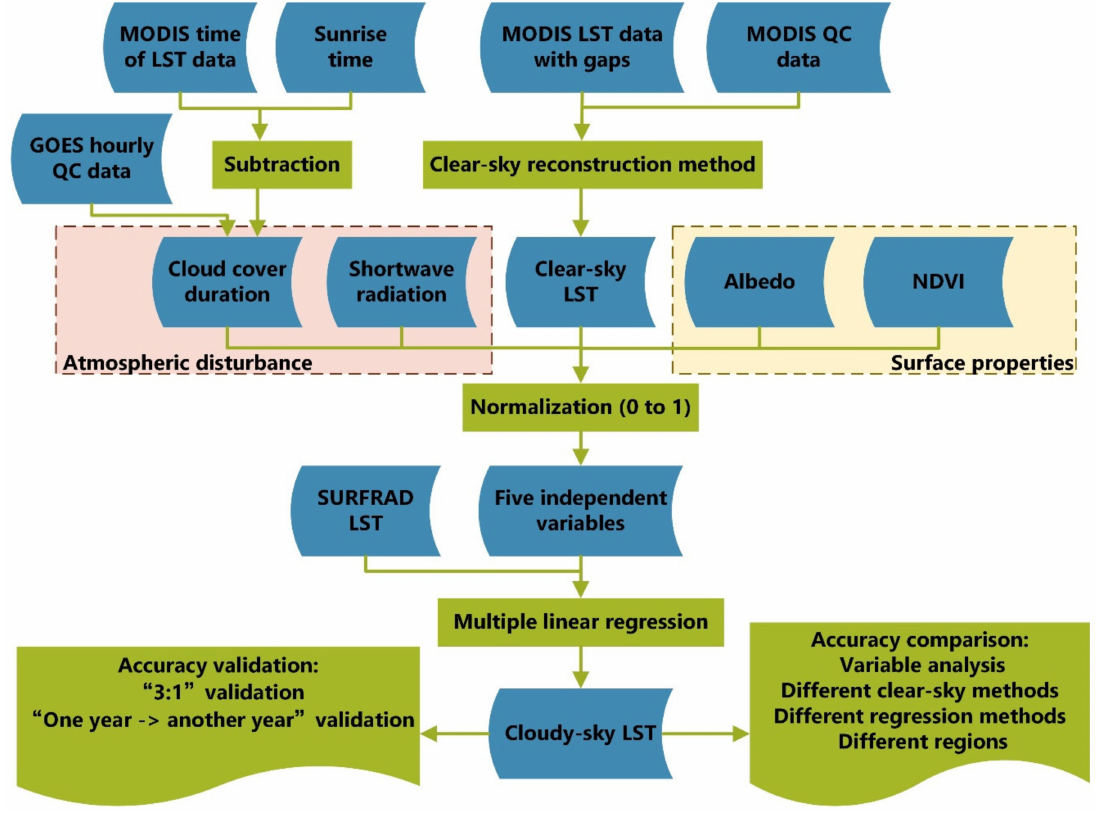
Figure 2. Flowchart of the cloudy-sky LST calculation model and accuracy